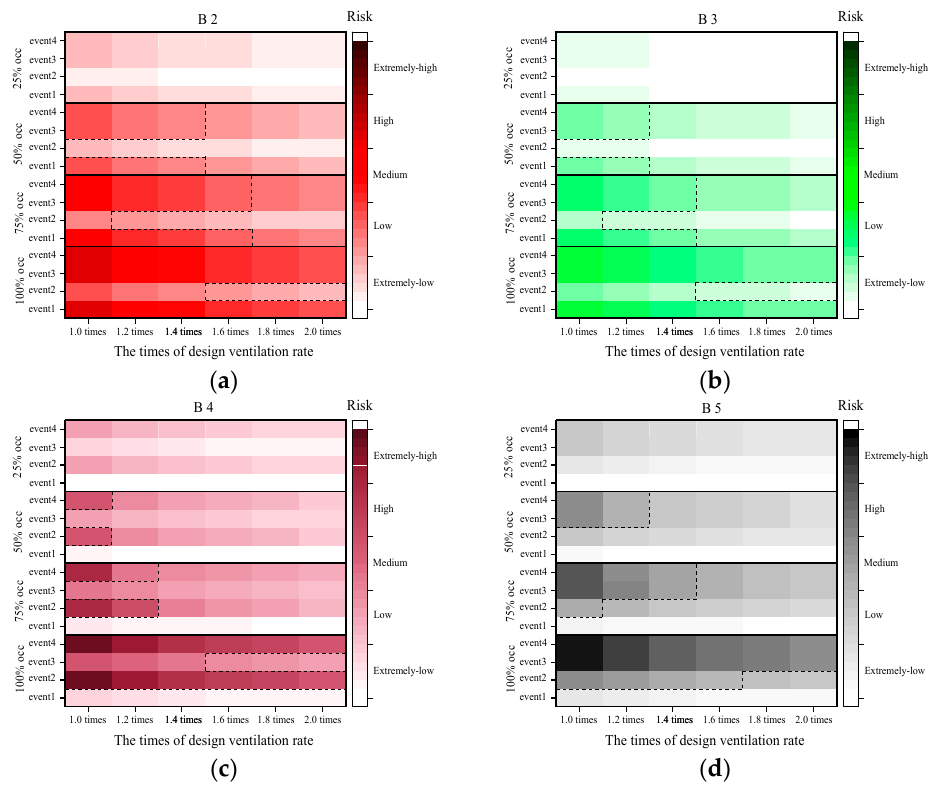
Figure 10. The distribution of infection risk under different limit-of-occupancy rates. ( a ) Lecture building, ( b ) Office building, ( c ) Canteen building, ( d ) Library building As shown, the design ventilation rate with 25% occupancy rate restriction during